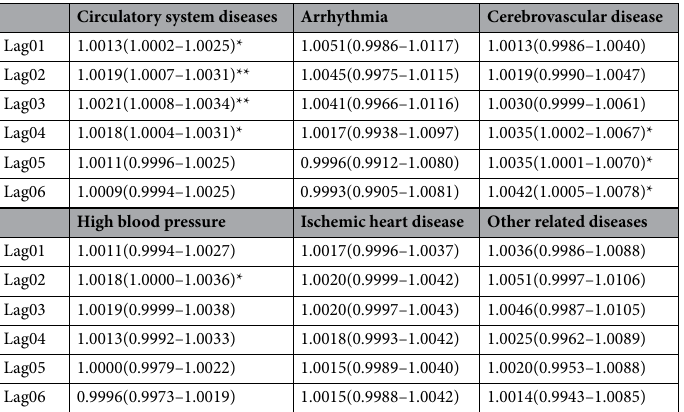
Table 2. Relative risks of emergency room visits for every 10 μg/m 3 increase in PM 10 at multiday lags. **P < 0.01, *P <